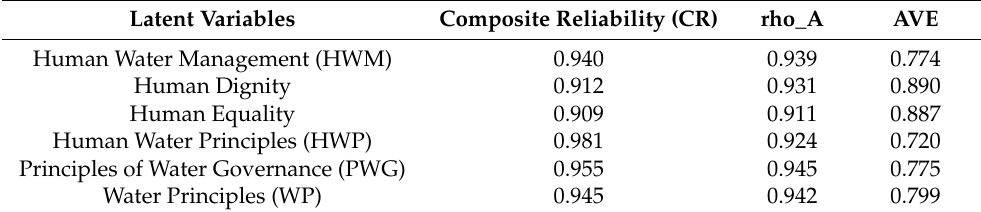
Table 3. Consistency and average variance extracted (AVE) of each latent